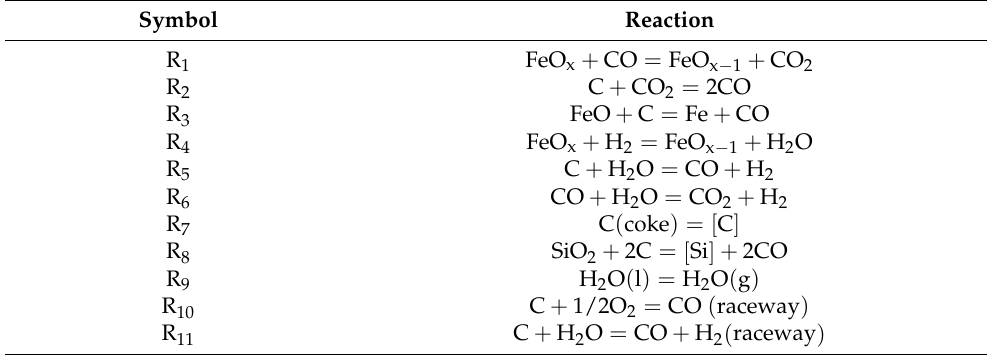
Table 2. Reactions in the 2D transient